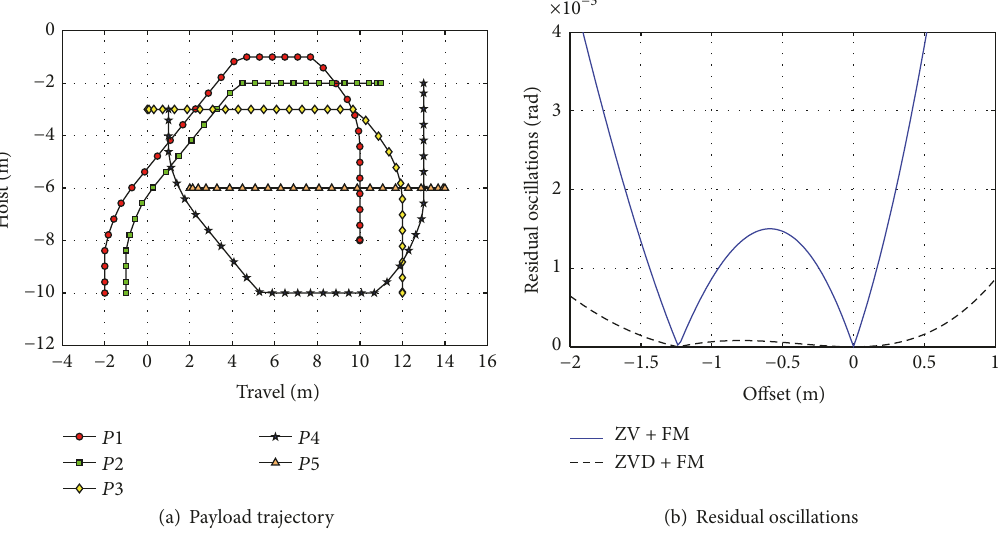
Figure 11: Simultaneous travel and hoisting maneuver using FM shaped command.